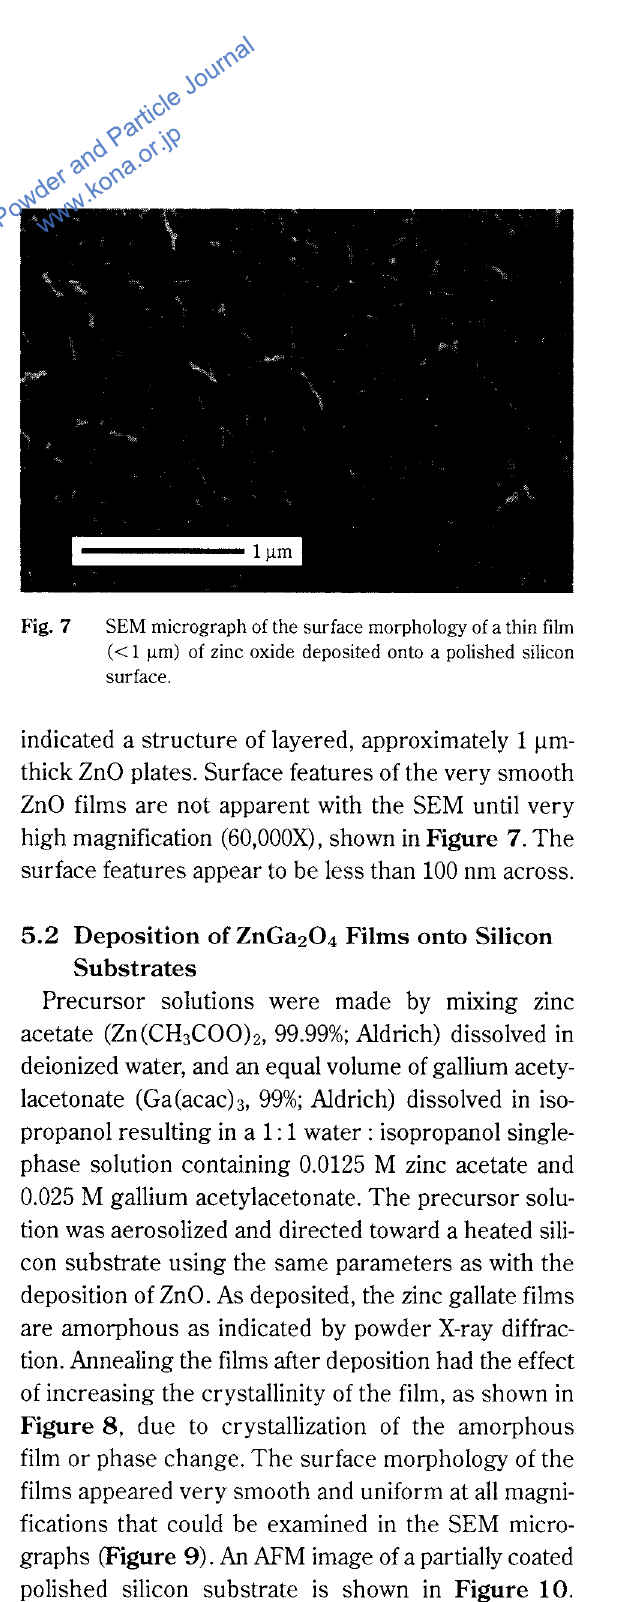
Fig. 10 AFM image of a thin film of zinc gallate deposited onto a polished silicon surface using supercritical C0 2 -assisted nebulization and